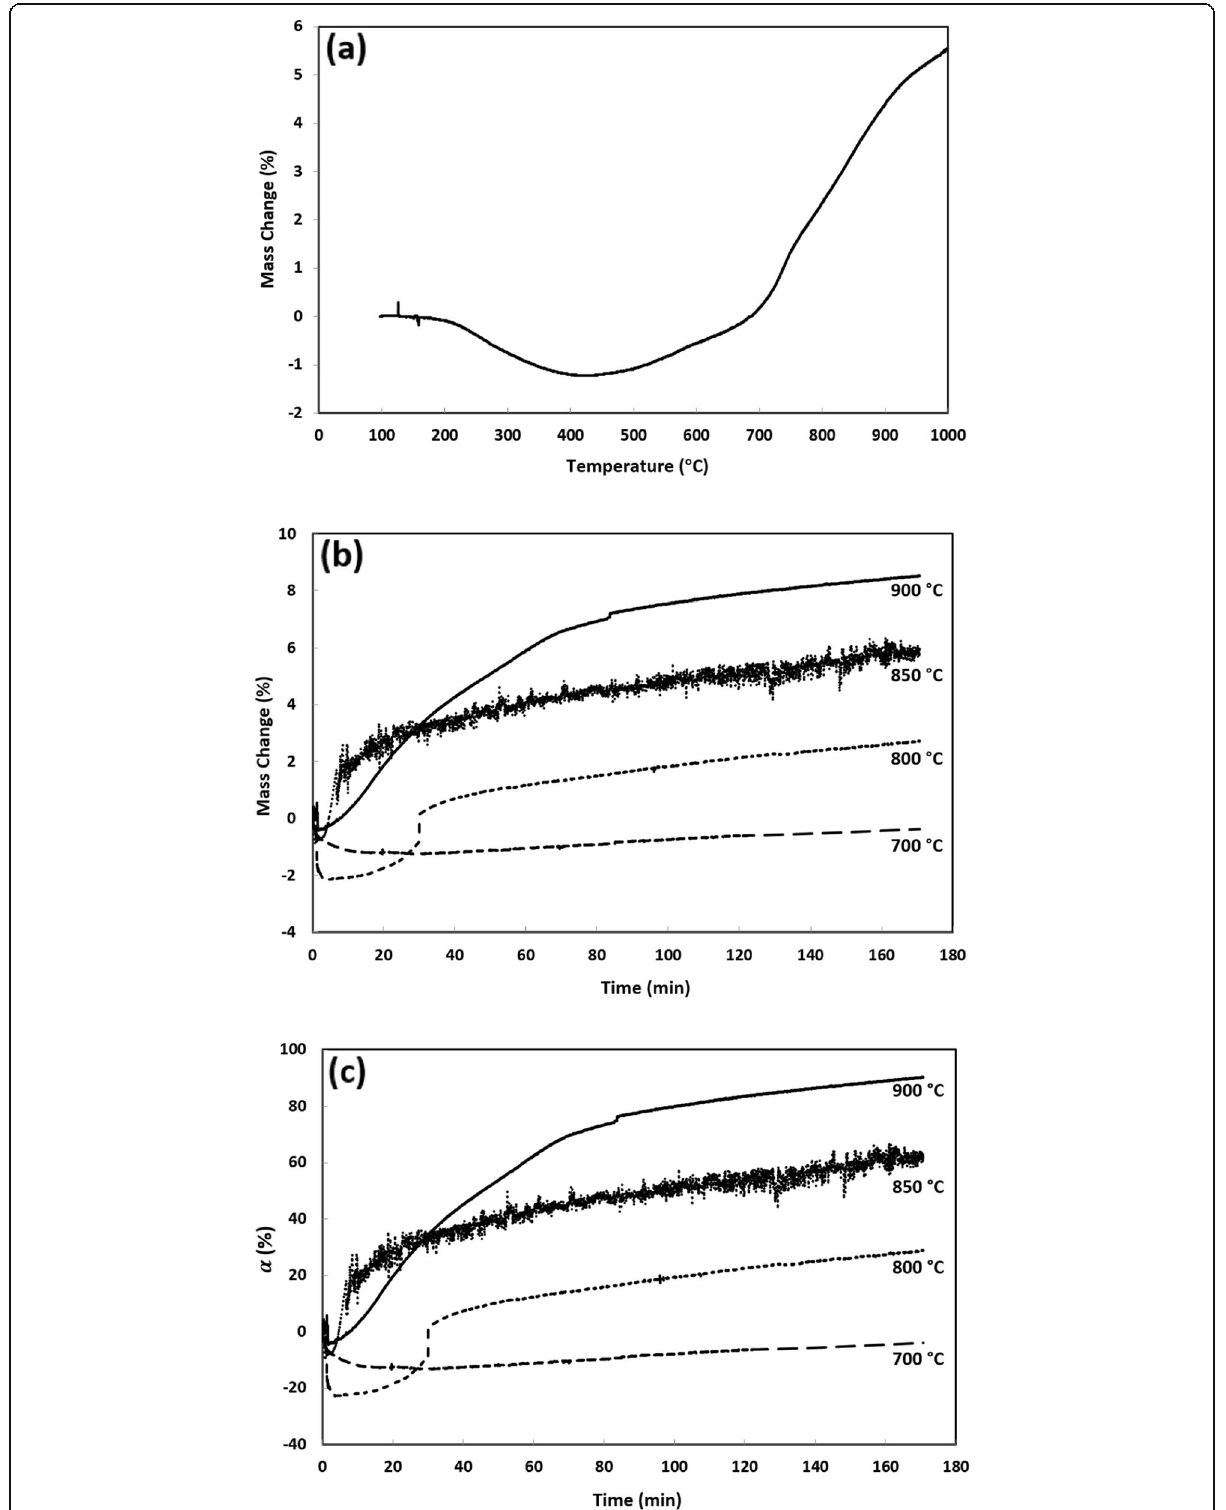
Fig. 1 Oxidation thermograms of brass slag in the air atmosphere. a Non-Isothermal oxidation by a heating rate of 10 °C min − 1 , ( b ) Isothermal mass change vs. time, and ( c ) Isothermal oxidation progress, α , vs.